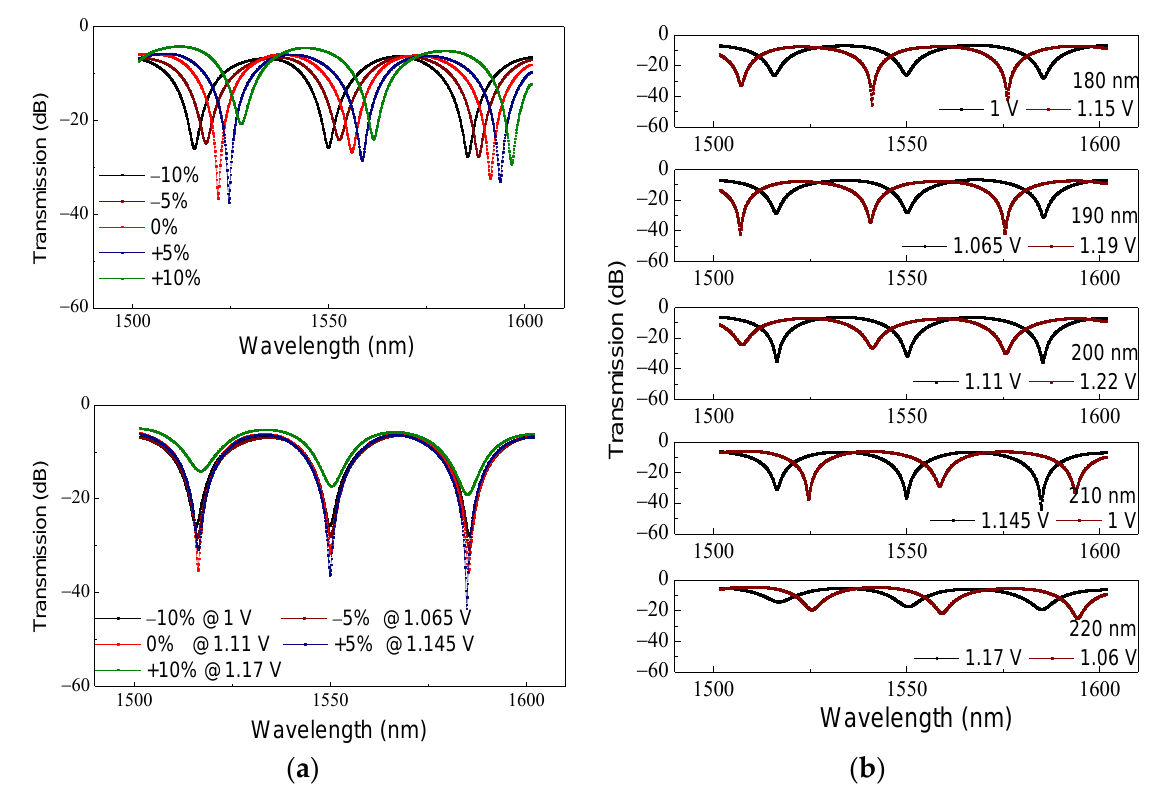
Figure 8. ( a ) The method of resonant turning by carrier concentration for different line widths; ( b ) the transmission curve of “on-state” and “off-state” for different line widths.